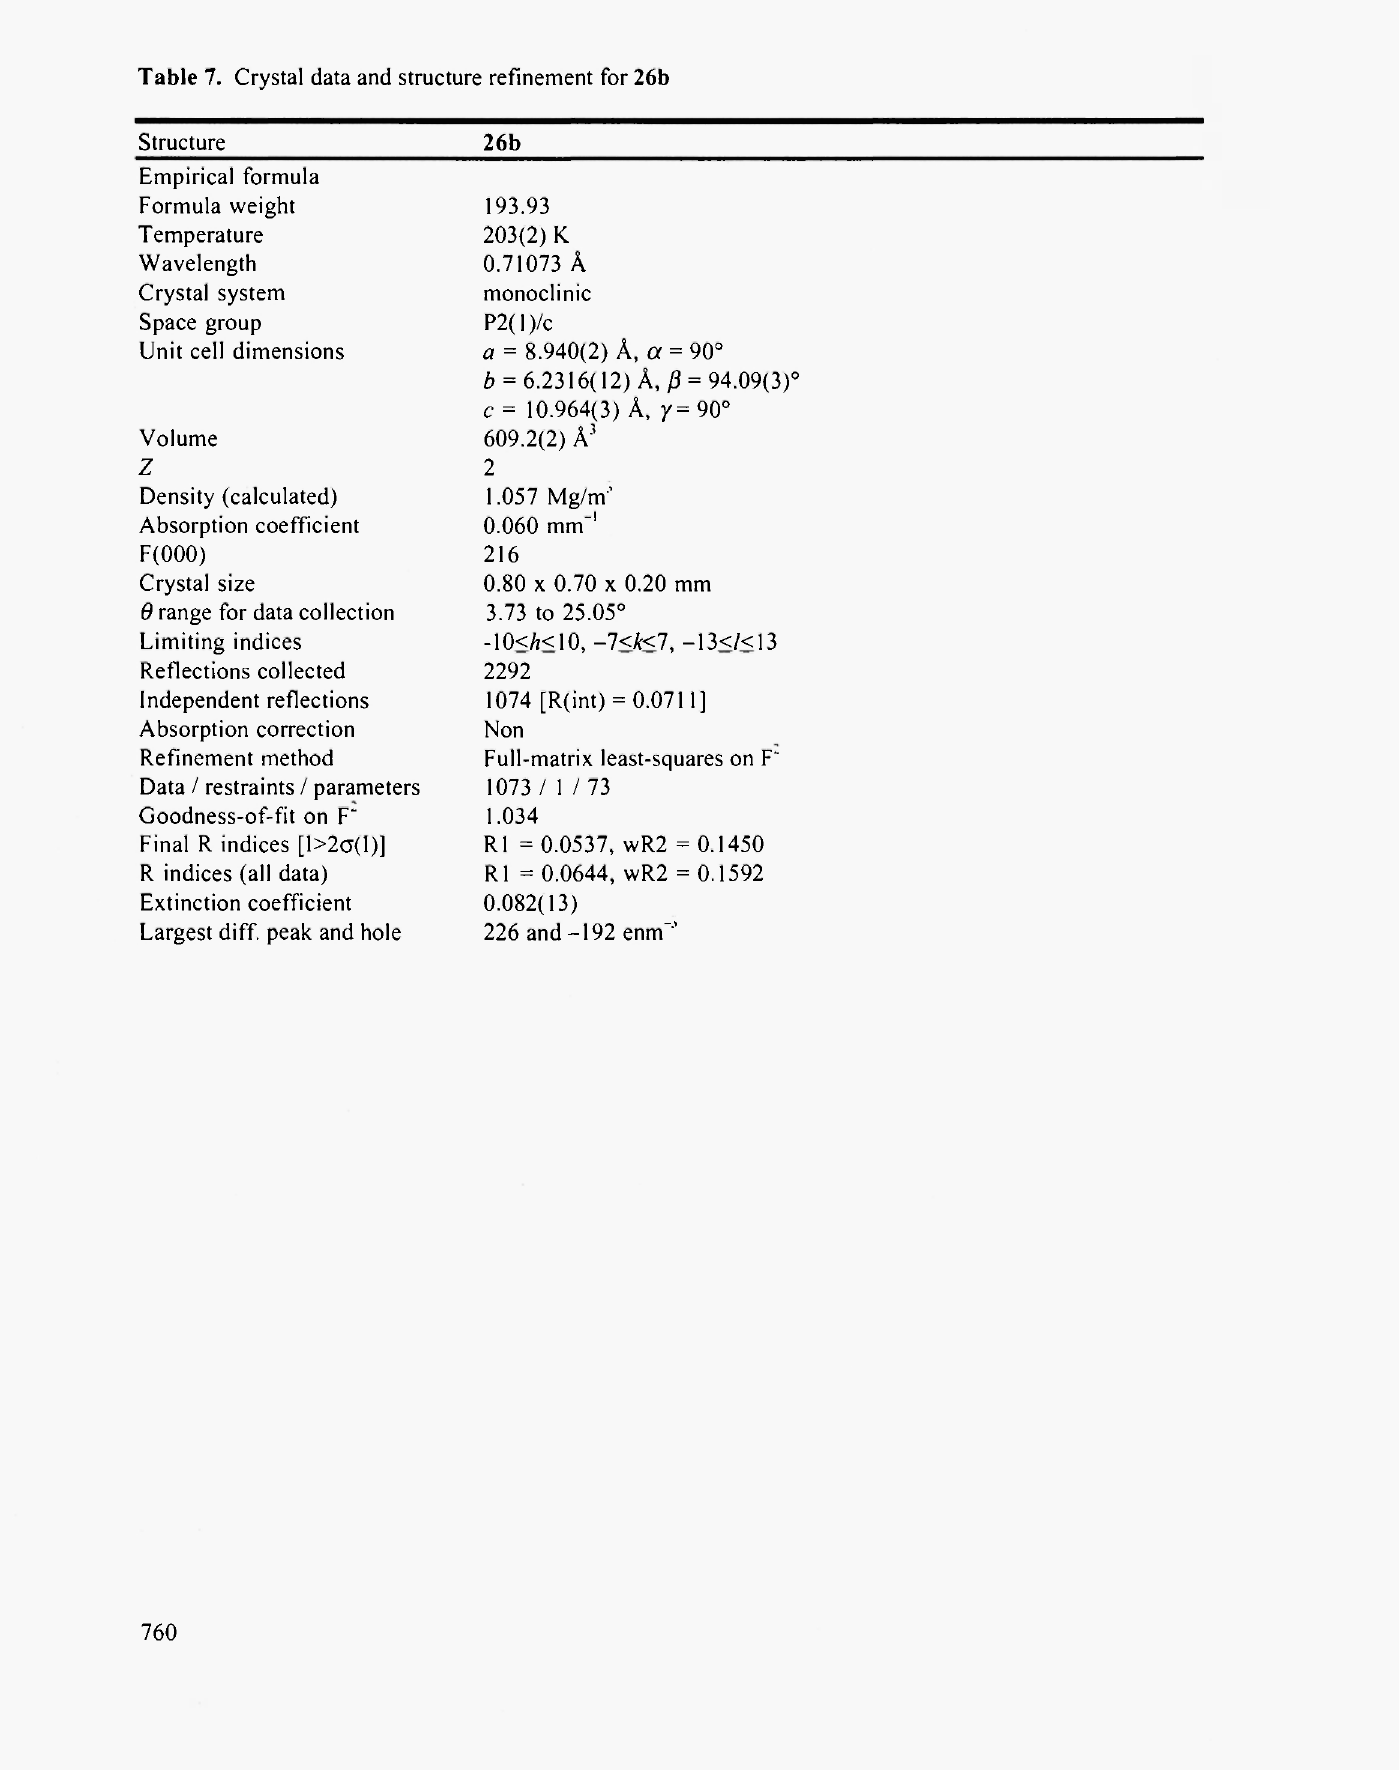
Table 7. Crystal data and structure refinement for 26b